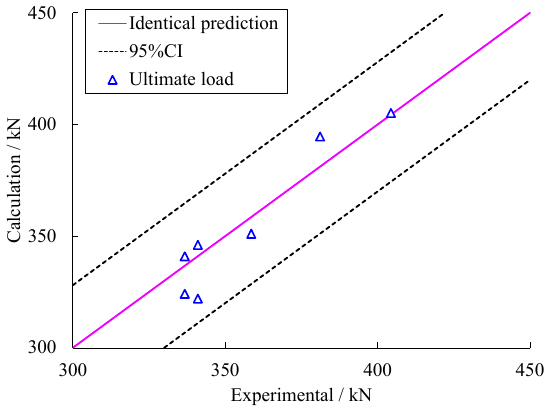
Figure 19. Comparison between calculations and measured results.